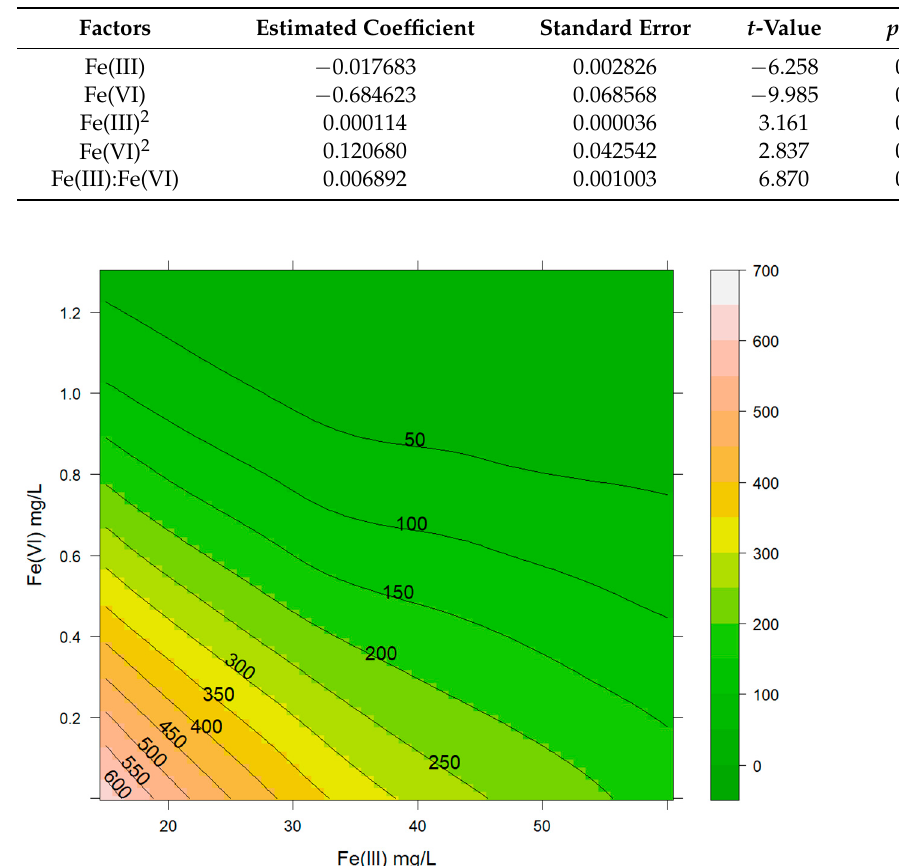
Figure 1. Local polynomial regression adjustment to assess the effects of Fe(III) and Fe(VI) on the final arsenic concentrations at the initial As(III) concentration of 1000 µ g L − 1